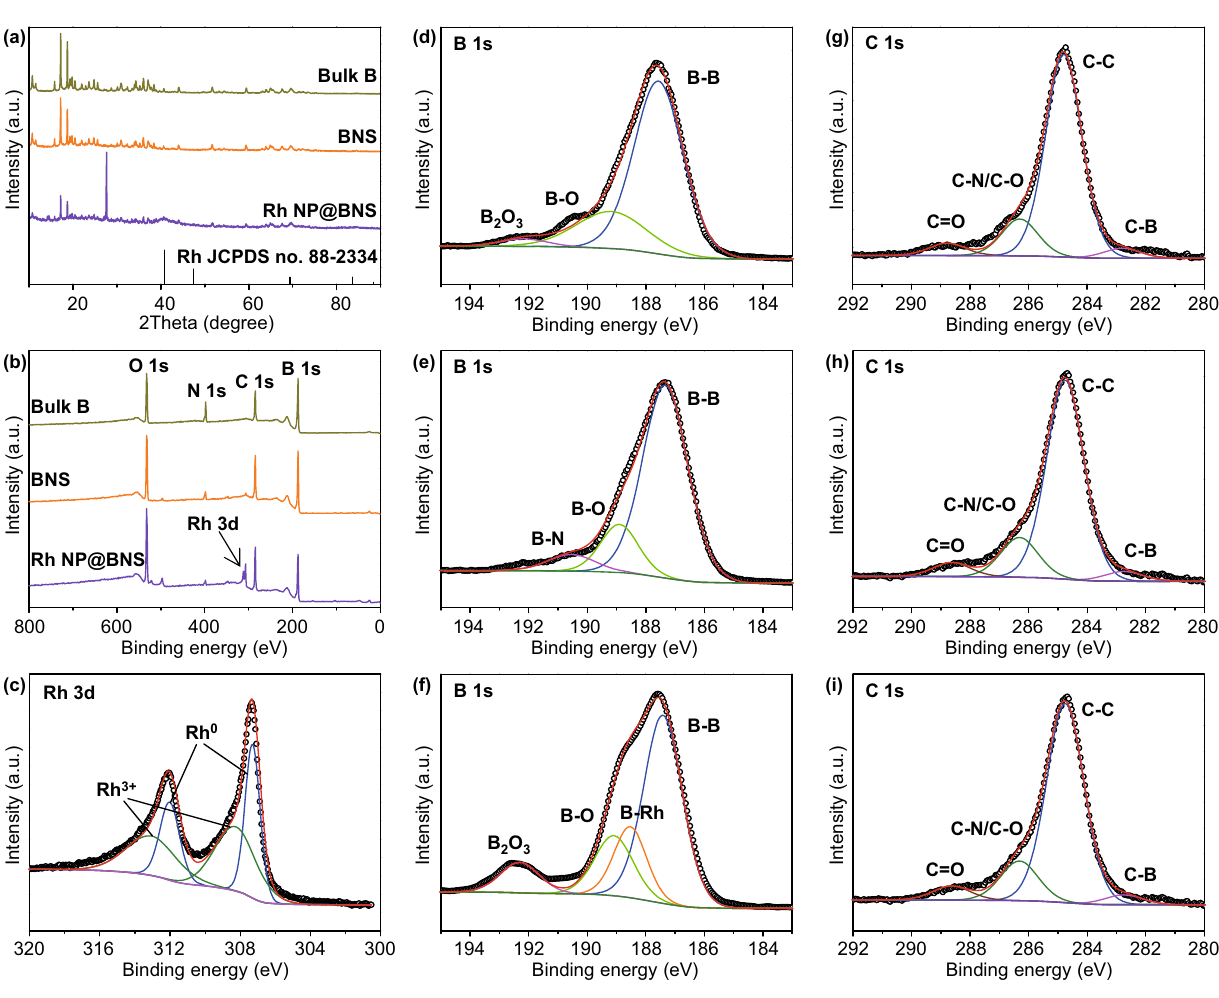
Fig. 2 a XRD patterns and b XPS survey spectra of bulk B, BNS, and Rh NP@BNS. c High-resolution spectra of Rh 3d of Rh NP@BNS. d - f High-resolution spectra of B 1 s and g - i C 1 s of bulk B, BNS, and Rh